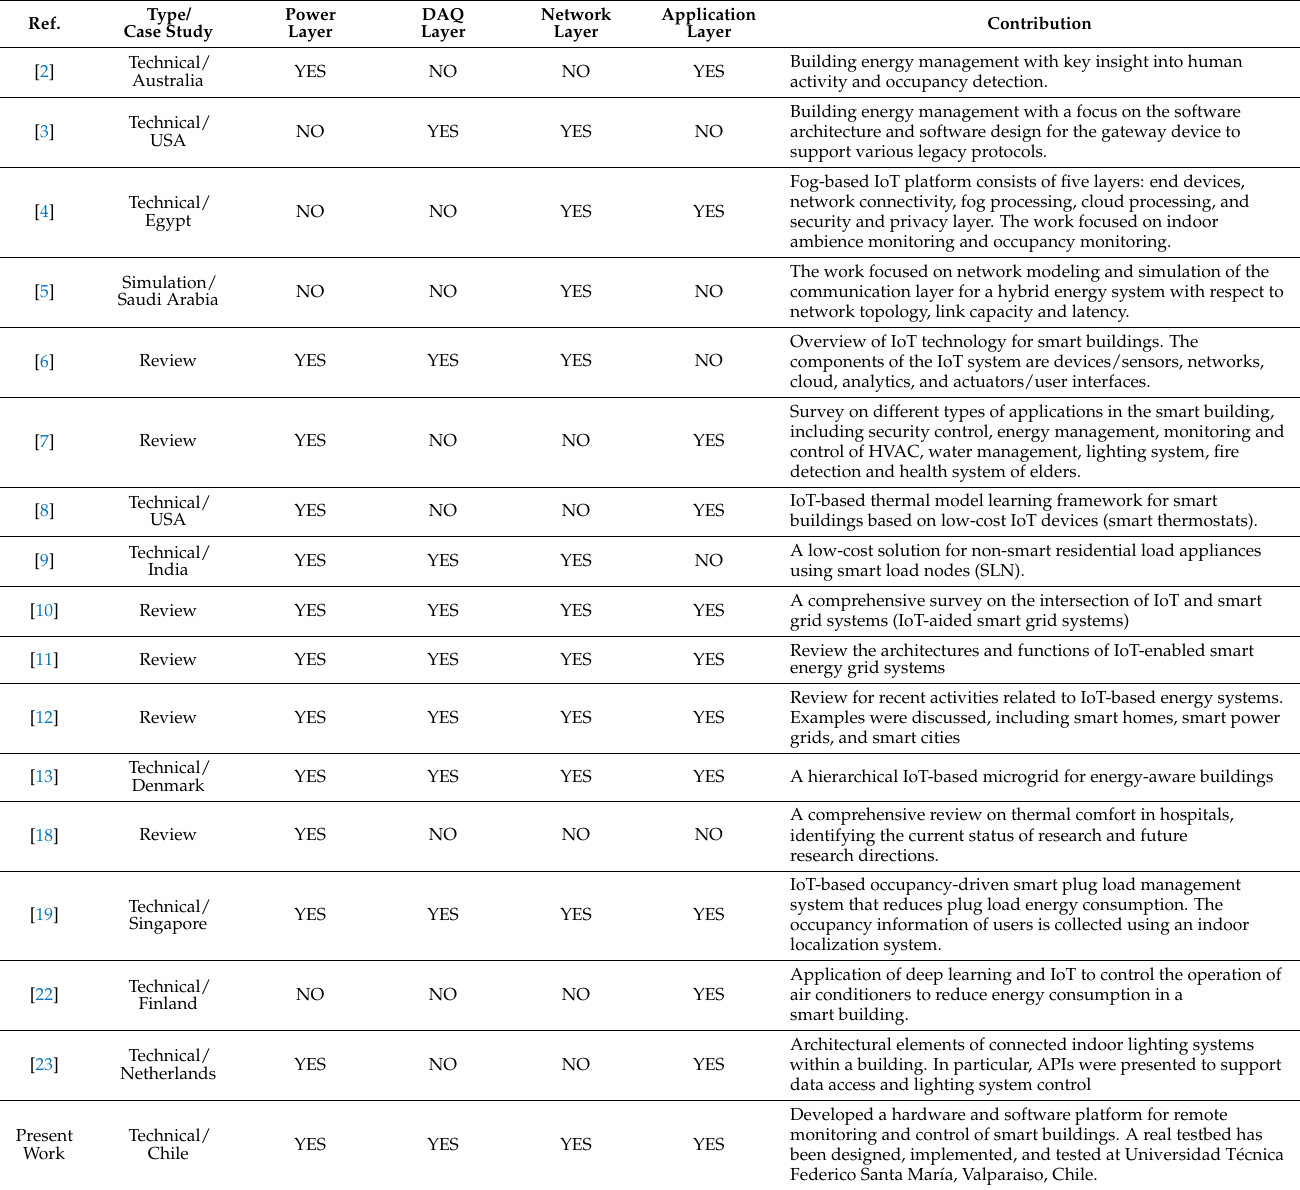
Table 1. Summary of related work for different IoT layers in related work for smart